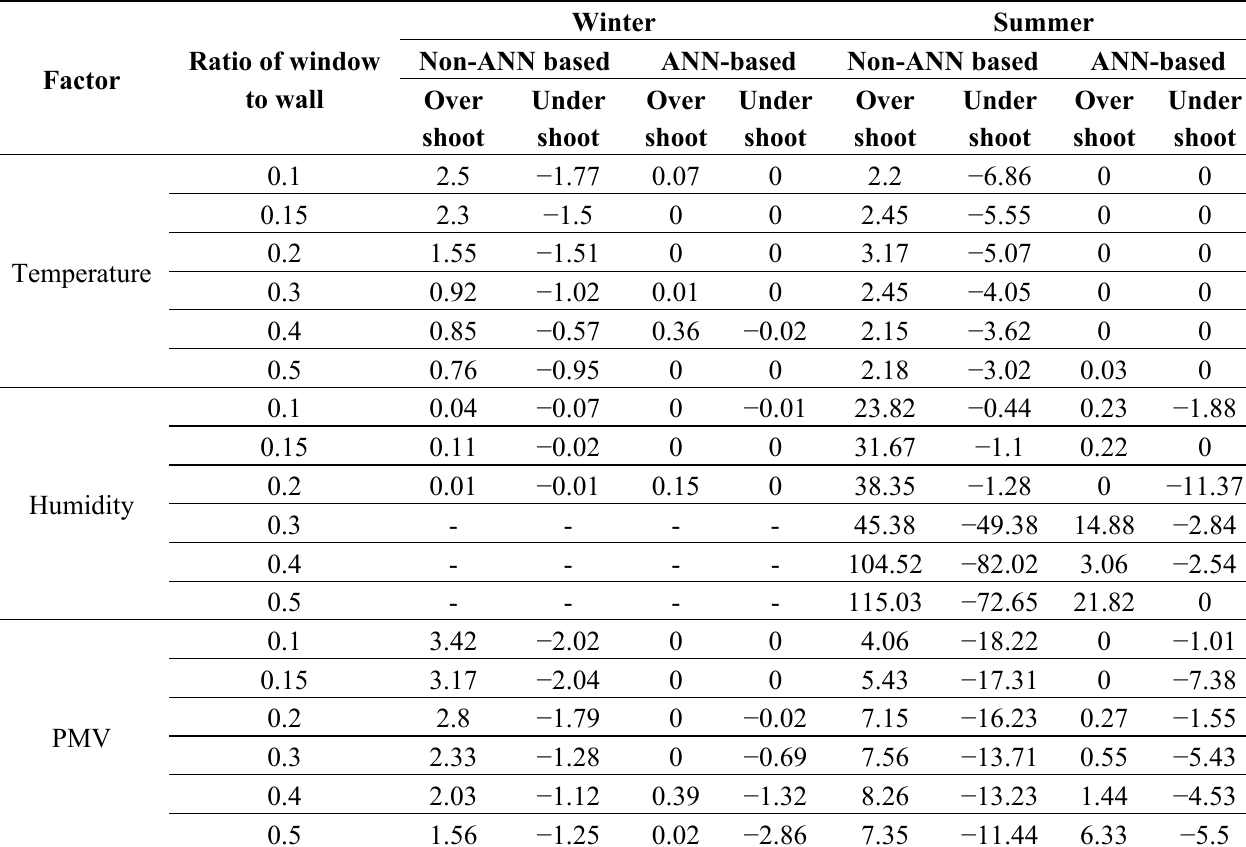
Table 11. A Magnitude of overshoots and undershoots of air temperature, humidity and PMV based on ratio of window to